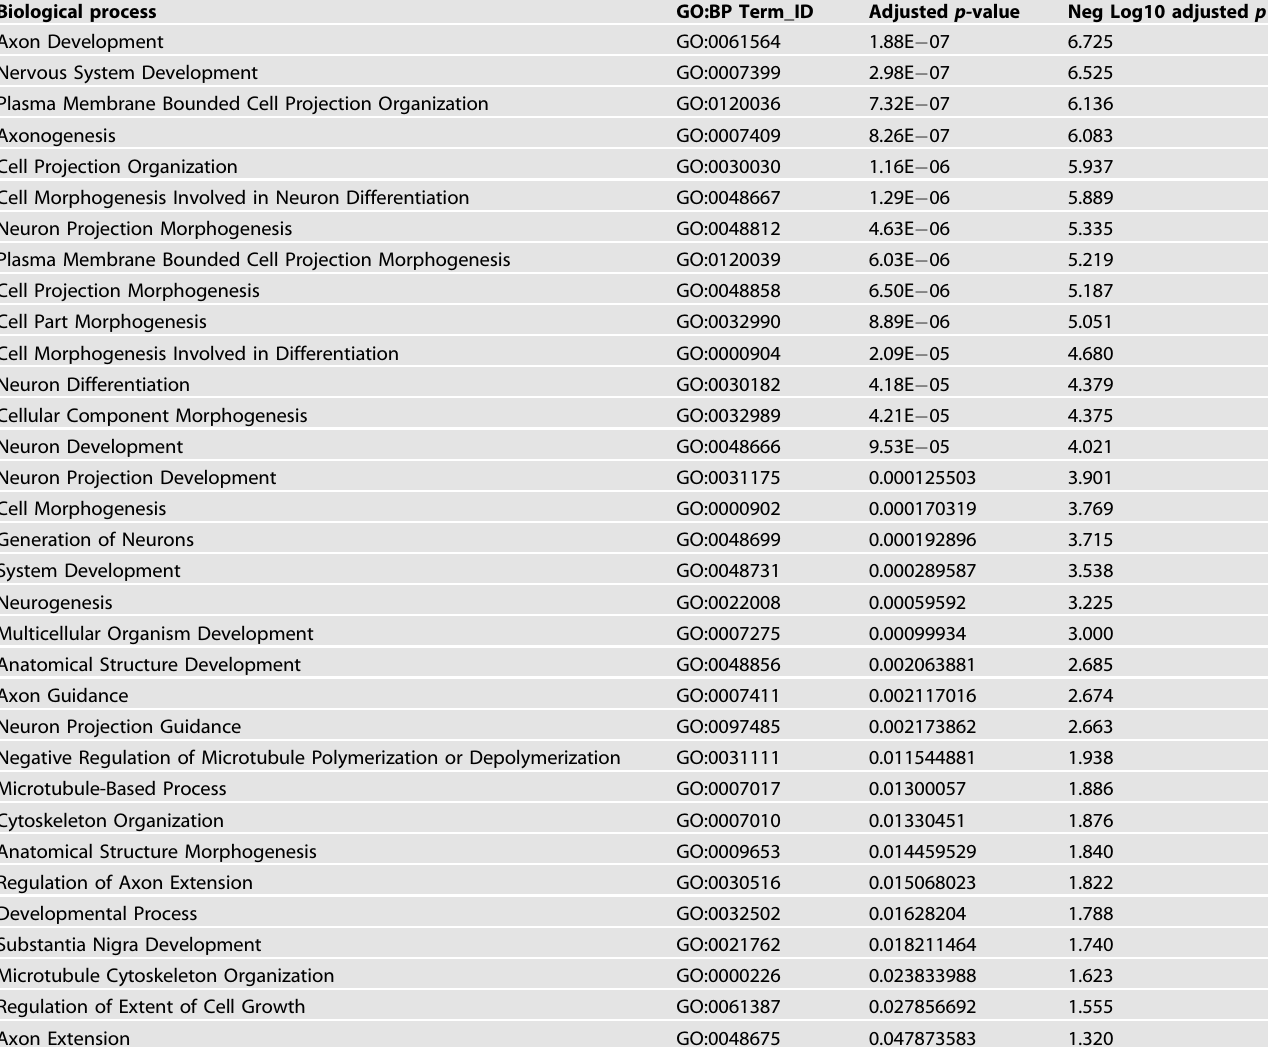
Table 3. Down-regulated GO biological processes in Scz organoids ( p <